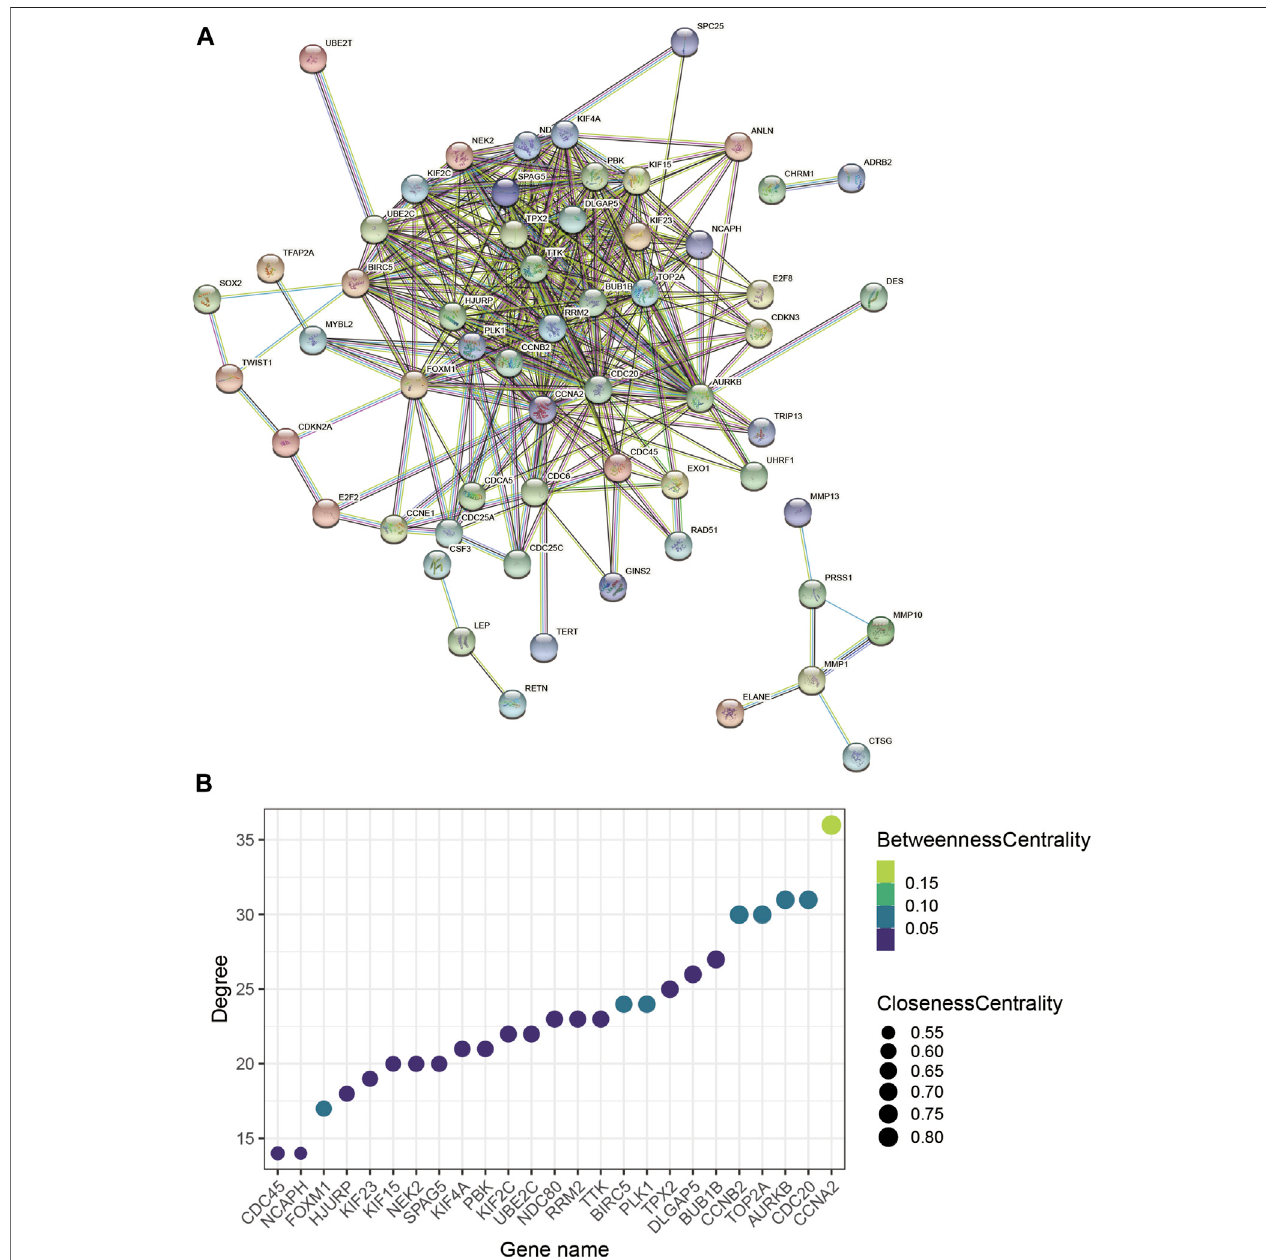
FIGURE 4 | PPI network analysis based on COVID-19/NSCLC interactional genes. (A) PPI network containing 59 nodes and 347 edges. (B) Bubble chart of the genes with degree value more than the two-fold median degree value in the whole network. Note: nodes represent interactional genes, and edges represent interaction relationships in panel (A)